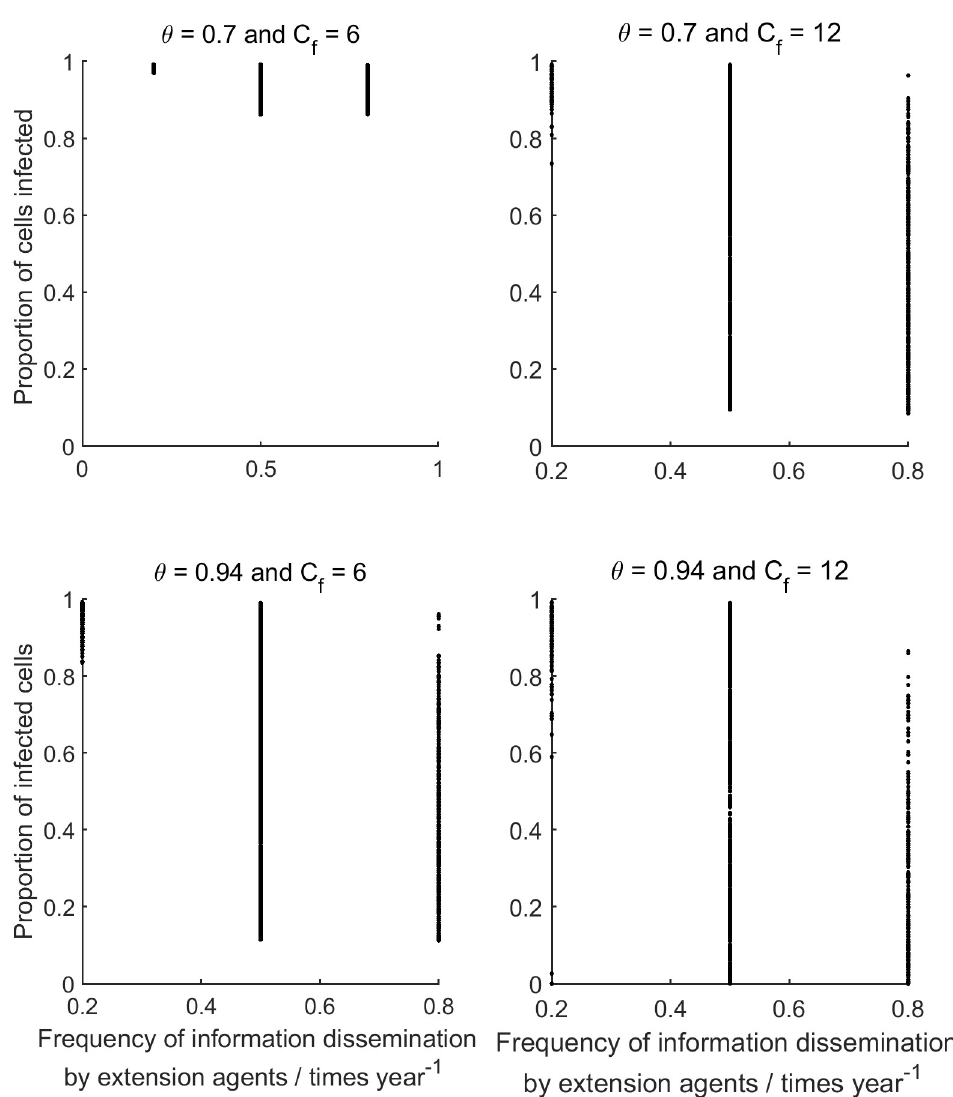
efficacy ( θ ) and spray frequency ( C f ). All other parameters values were varied as described in Table 2 resulting in the ranges of outcomes observed for each combination of θ and C